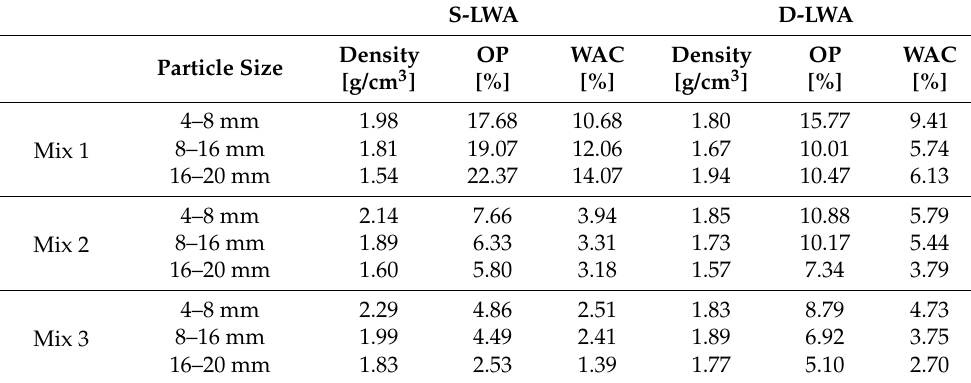
Figure 1. Single lightweight artificial aggregates (S-LWAs) and double lightweight artificial aggregates (D-LWAs). Table 4. Physical properties of the manufactured aggregates.